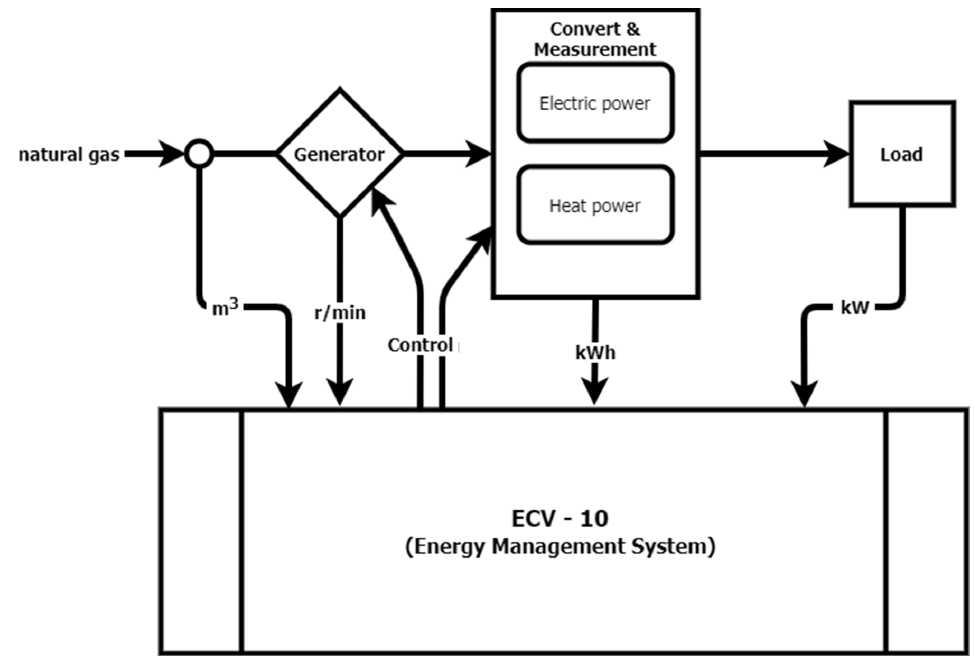
Figure 4. The experimental set-up for real time efficiency calculation to determine the efficiency hill of the implemented microgeneration system.